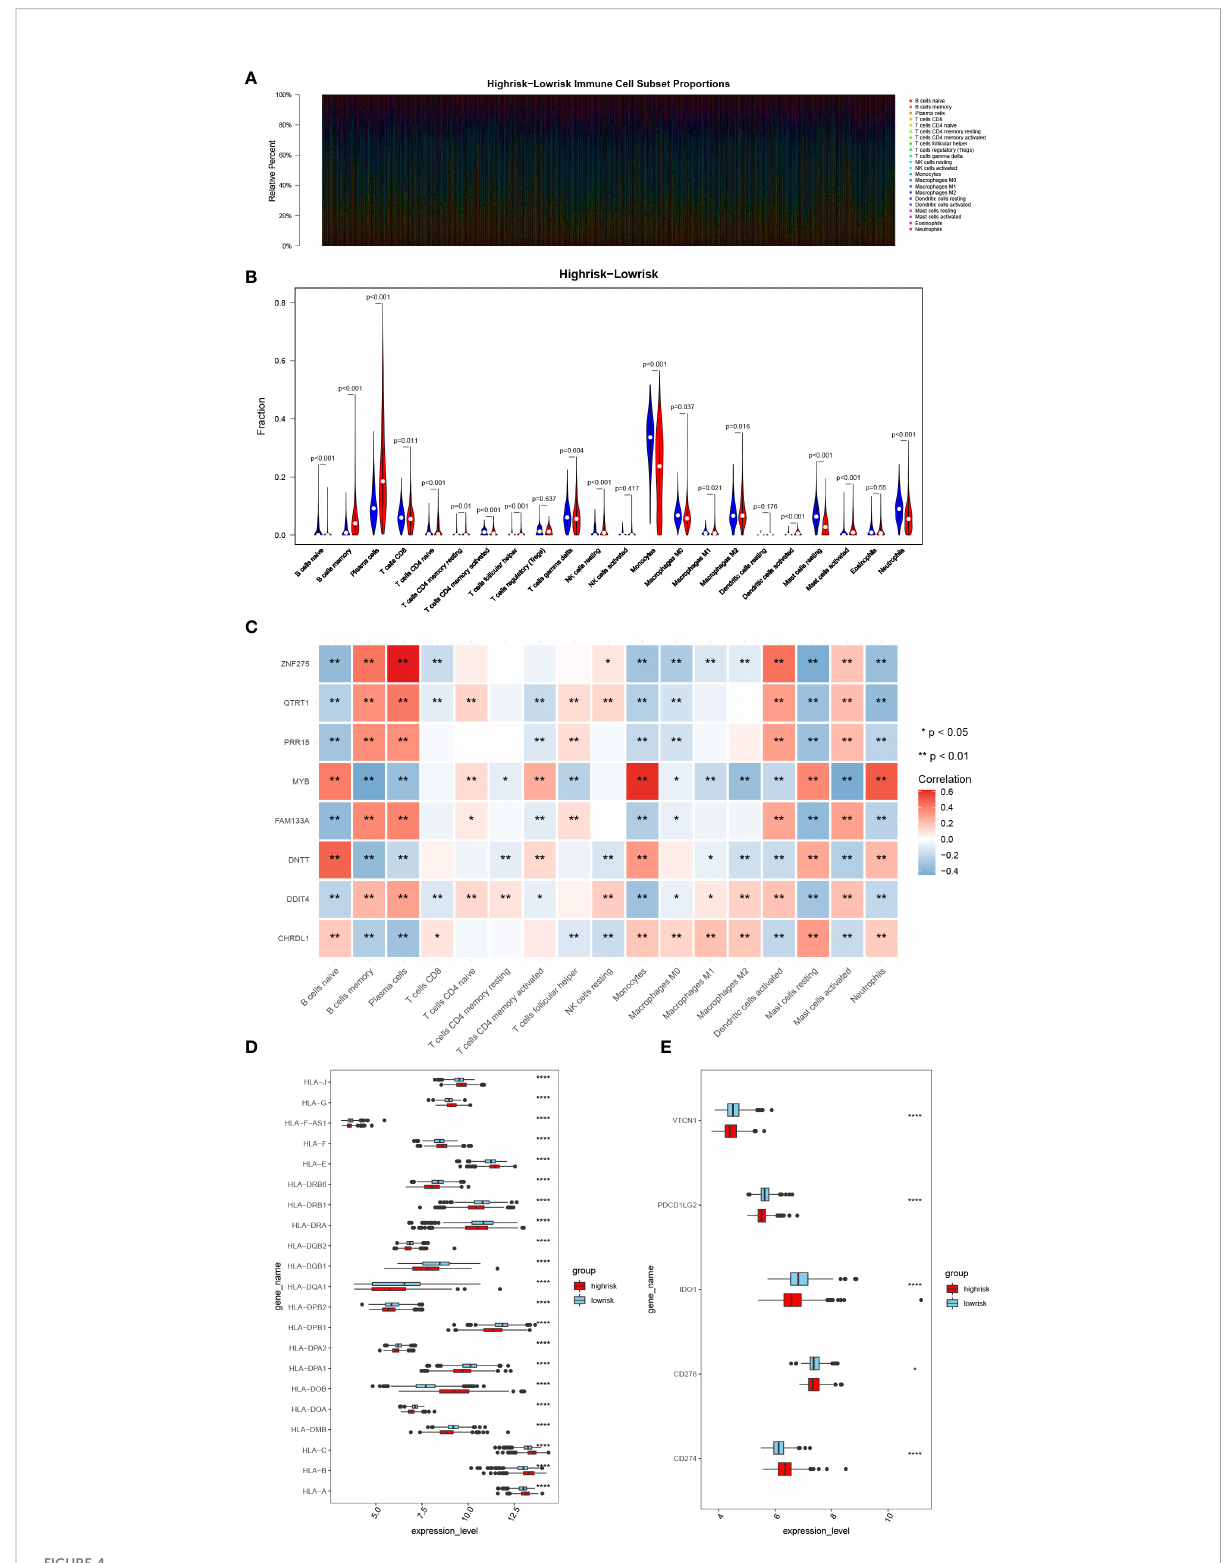
FIGURE 4 Analysis of immune in fi ltration and immunotherapy responses in high- and low-risk groups. (A) Heatmap of immune cell subset proportions. (B) Violin plot of the in fi ltration abundance of 22 immune cell types in two groups. (C) Heatmap of the correlation between signatures and differentiated immune cells. (D, E) The HLA family and immune checkpoint genes expression in the two groups. (*, p< 0.05; **, p< 0.01; ****, p< 0.0001; vs.